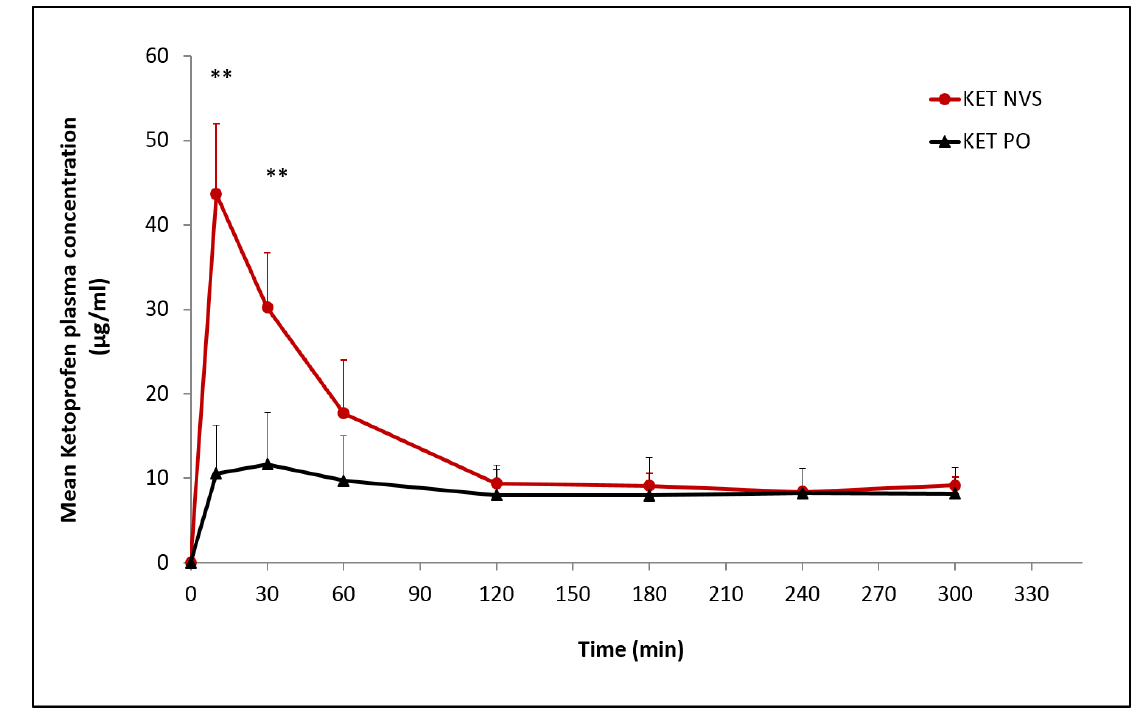
Figure 3. Pharmacokinetic profile of Ketoprofen in plasma following nasal administration of the drug nanovesicular system (KET-NVS), as compared to oral preparation (KET-PO), each at a drug dose of 14 mg/kg, (n, 5 for each group), (Mean ± SD). ** p < 0.01 KET-NVS vs. KET-PO at 10 min, and 30 min. Table 4. Pharmacokinetic (pK) parameters for Ketoprofen following nasal administration in the nanovesicular system (KET NVS) as compared to oral preparation (KET PO), (Mean ± SD), (Values obtained using the NCOMP